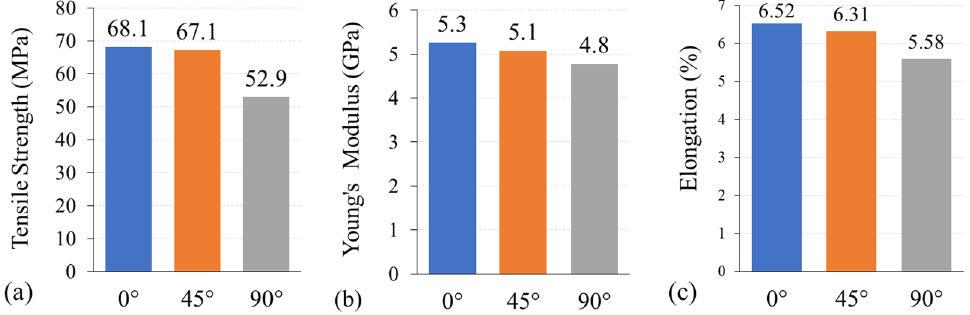
Figure 2. Influence of raster angle on PLA ( a ) tensile strength, ( b ) Young’s modulus, and ( c ) % elongation.